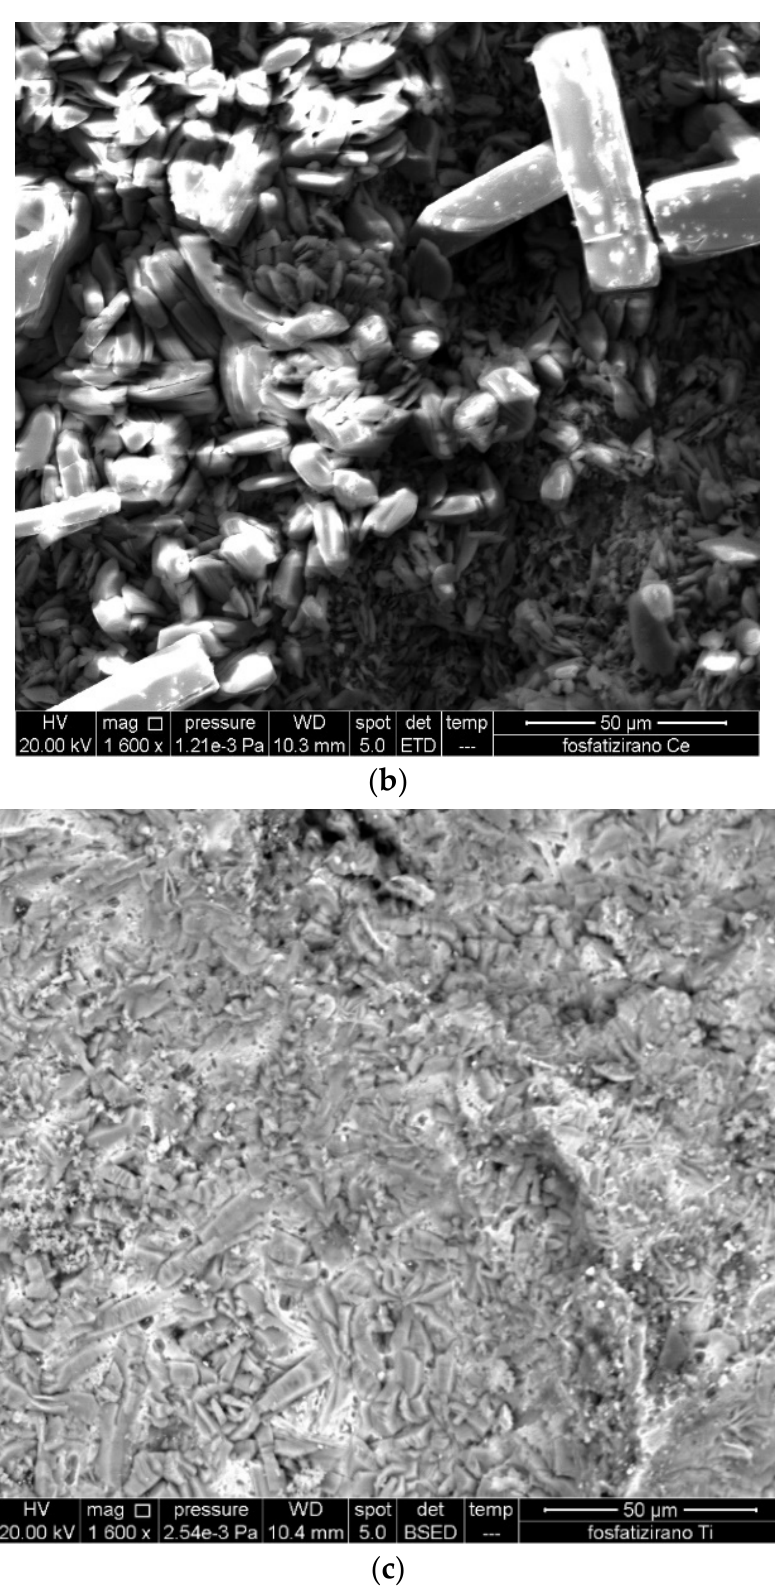
Figure 1. SEM micrographs phosphating carbon steel surface with Ni 2+ ions ( a ), Ce 3+ ions ( b ) and with Ti 2+ ions ( c ).